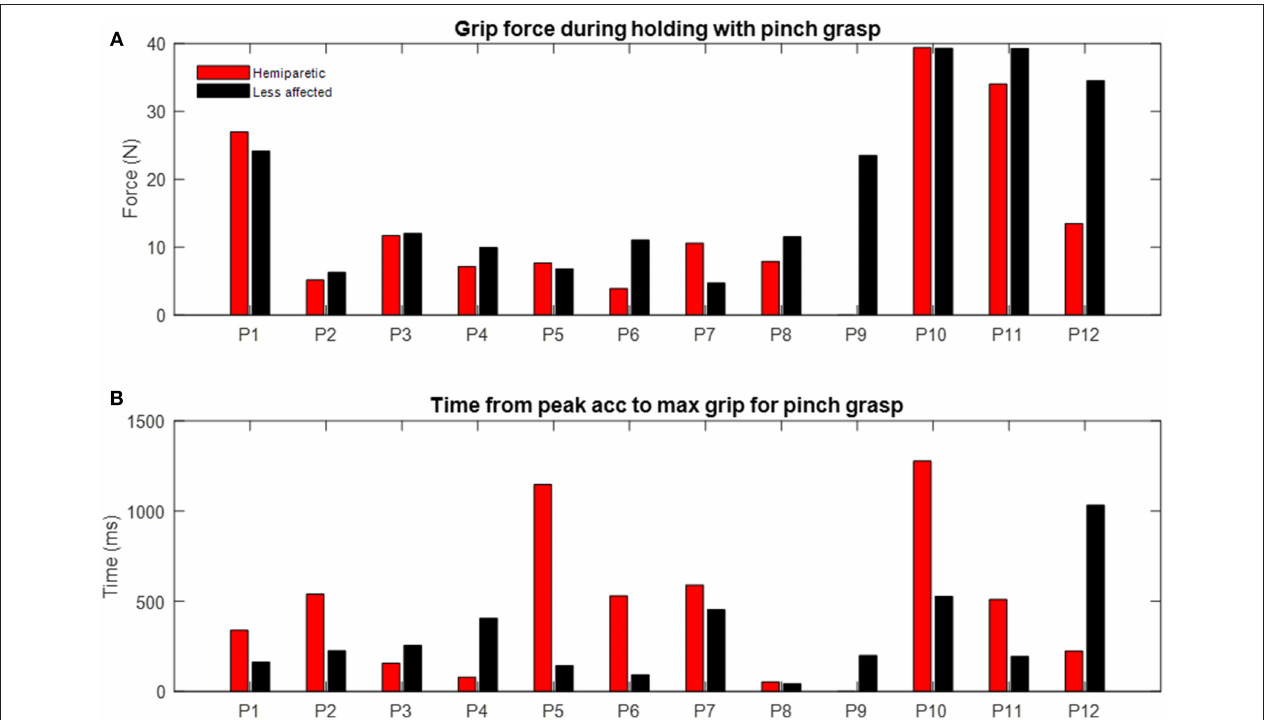
FIGURE 8 | Examples of individual differences during pinch grasp with hemiparetic (red) and less affected arms (black). (A) Grip force during holding. Each bar represents median grip force recorded for each patient. (B) Time delay from peak acceleration to maximum grip force. Each bar represents mean of time delay over three